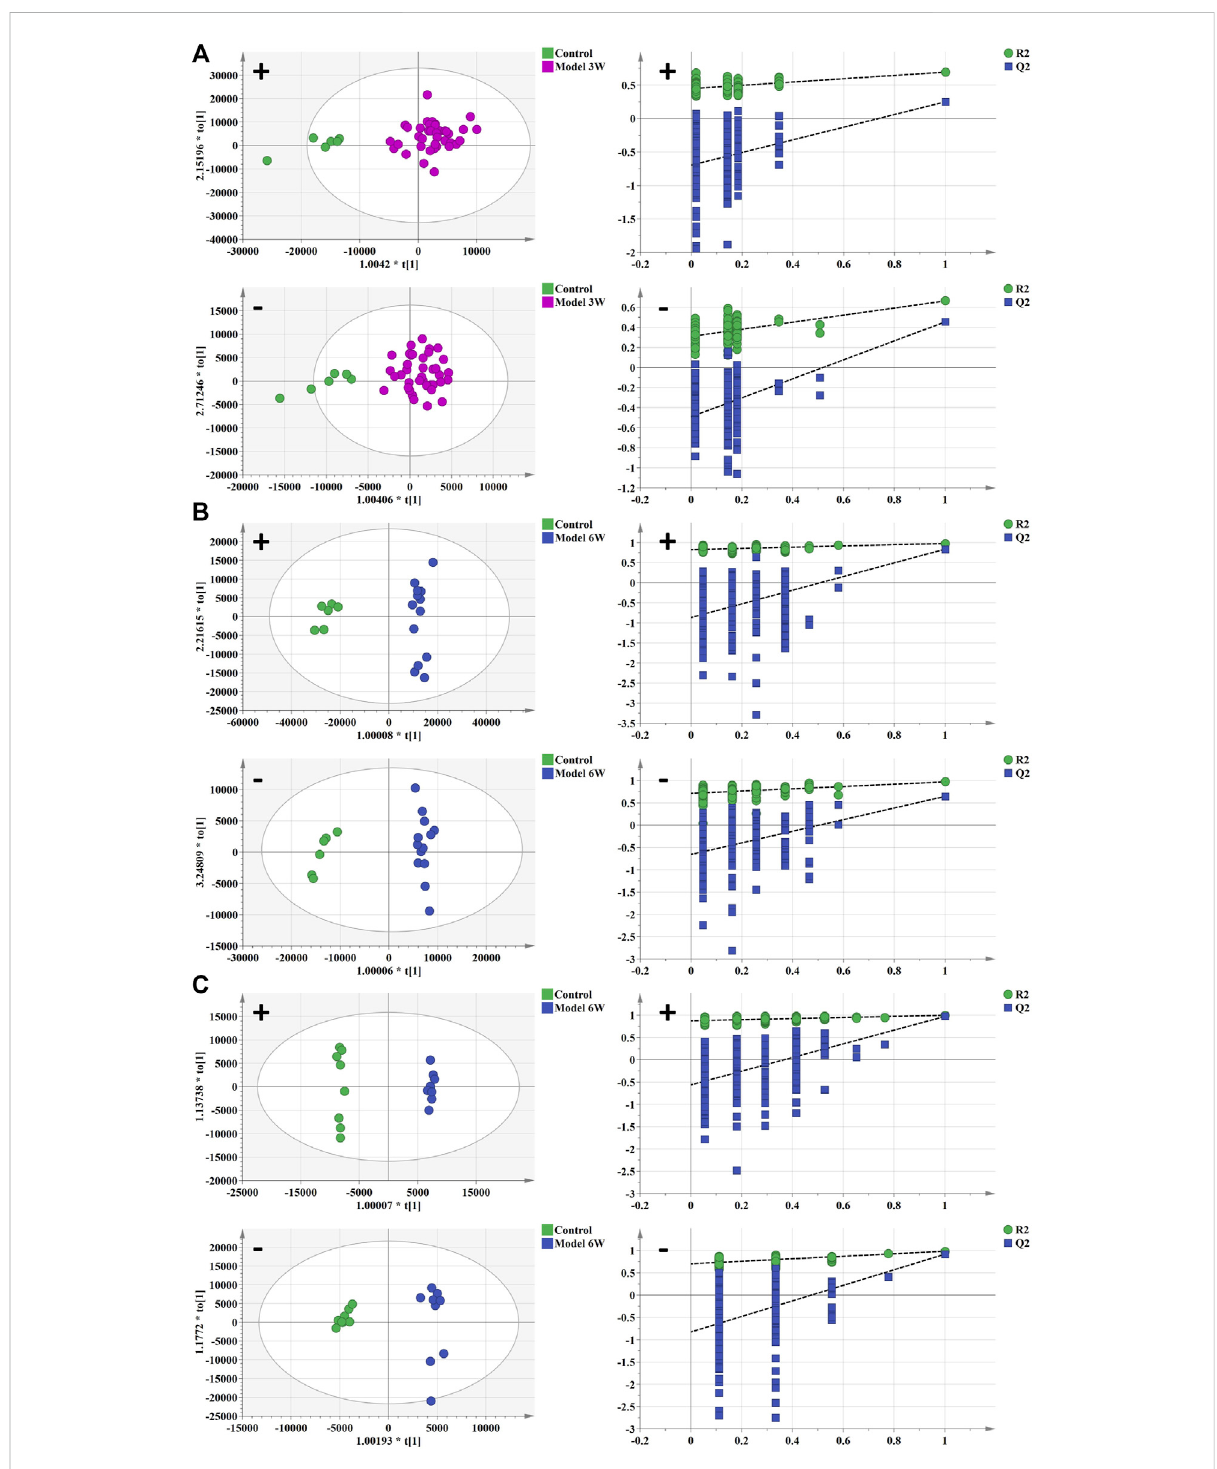
FIGURE 2 The OPLS-DA analysis and permutation test of serum and liver in positive and negative ion mode of control group, early stage of HCC, and formative stage of HCC. (A,B) serum metabolism pro fi le and (C) liver metabolism pro fi le. Green spot represents the control group, purple spot represents the early stage of HCC, and blue spot represents the formative stage of